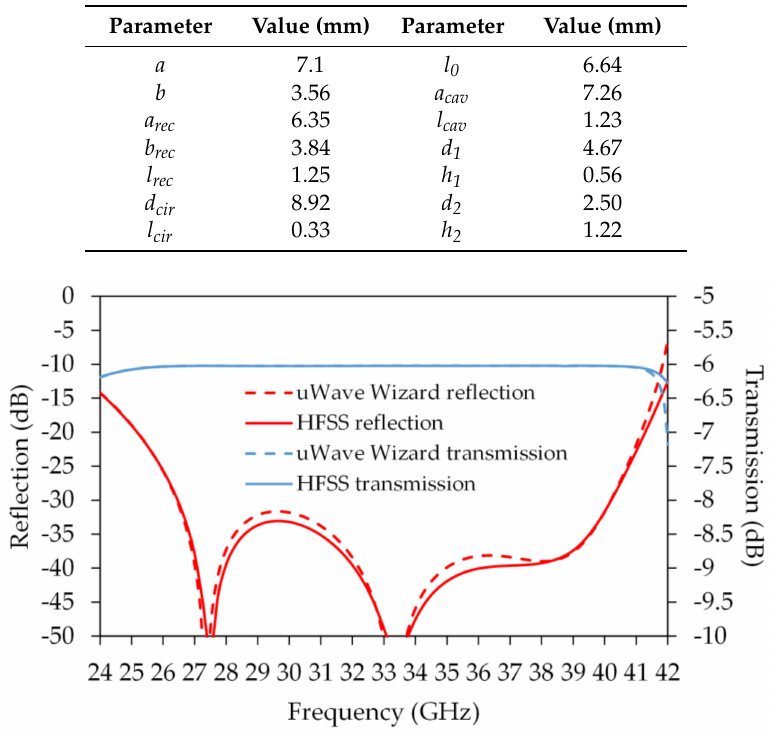
Figure 3. Simulated performance of the proposed junction; reflection at common port in red lines and input-output transmission in blue lines. Results from µ Wave Wizard in dashed lines and from HFSS in solid